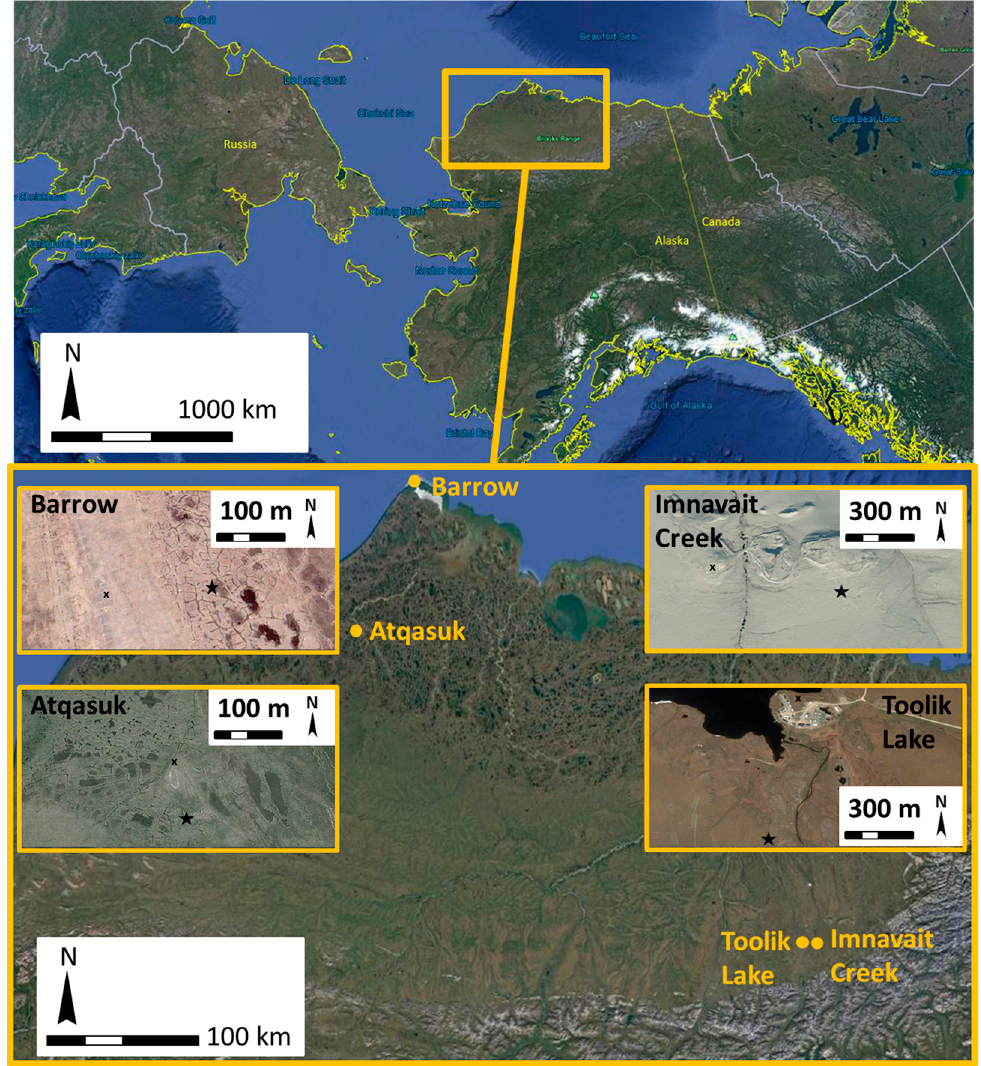
Figure 1. Locations of Mobile Instrumented Sensor Platform (MISP) system transects (stars)